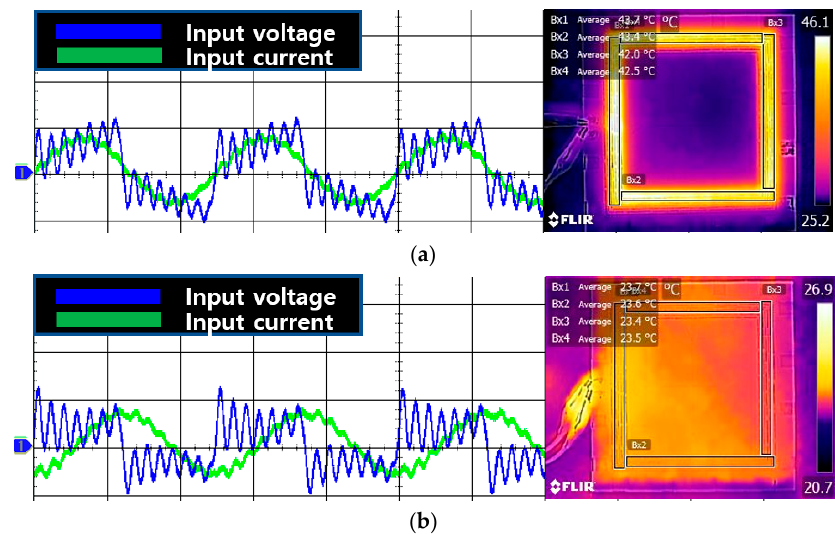
Figure 8. Transient waveforms of input voltage and current with temperature in wearable textile heater for ( a ) aligned and ( b ) misaligned Tx and Rx coils.